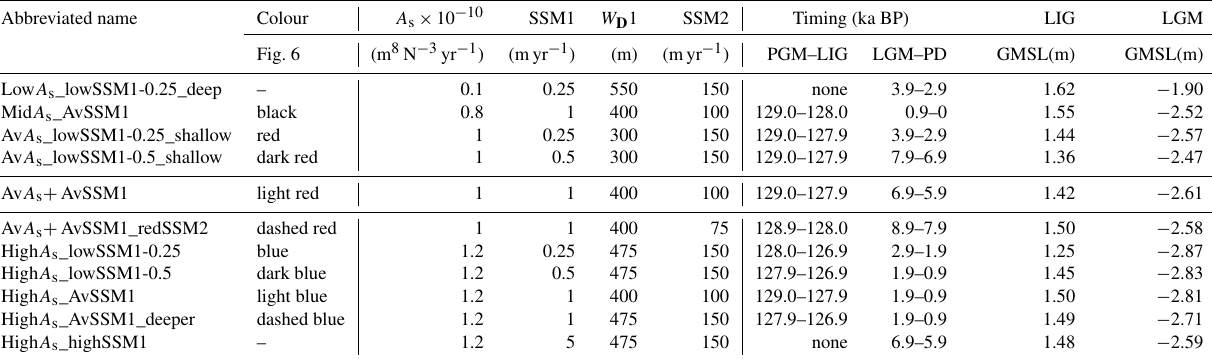
Table 3. Set of optimum parameters which resulted in a growth beyond the PD margin during glacial maximums (PGM and LGM) and a retreat by the present day (PD). Note that W D 2 is constant in all simulations (1000m). The simulation highlighted in grey is shown in Fig. 5. The timing of the retreat across the Nares Strait for two interglacials is given in ka BP: PGM–LIG and LGM–PD, along with the total global mean sea level (GMSL) contribution from the GrIS only for the Last Interglacial (LIG) and the Last Glacial Maximum (LGM). The GMSL was calculated using the simulated ice